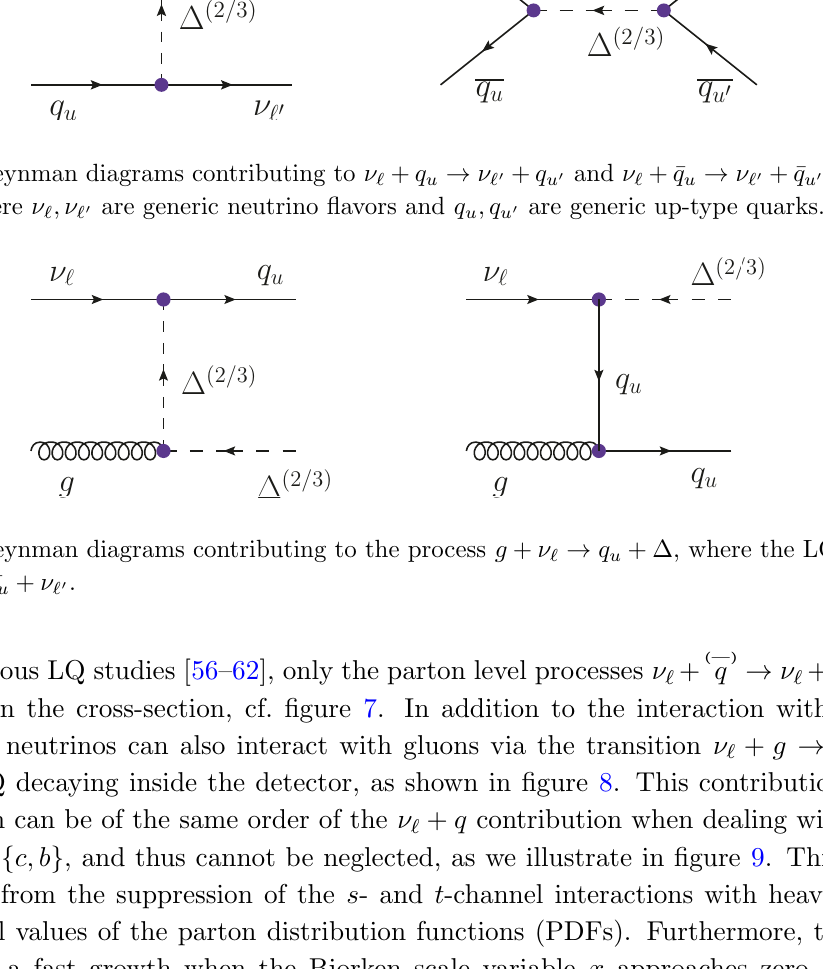
(cid:23) ‘ 0 + q u 0 and (cid:23) ‘ + (cid:22) q u (cid:23) ‘ 0 + (cid:22) q u 0 via a LQ ! !